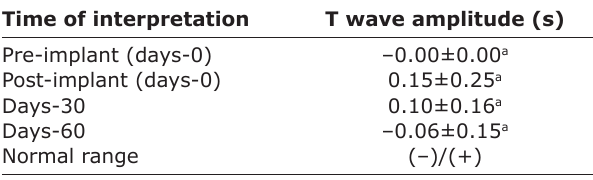
Table-11: The average amplitude of T wave of the pigs.